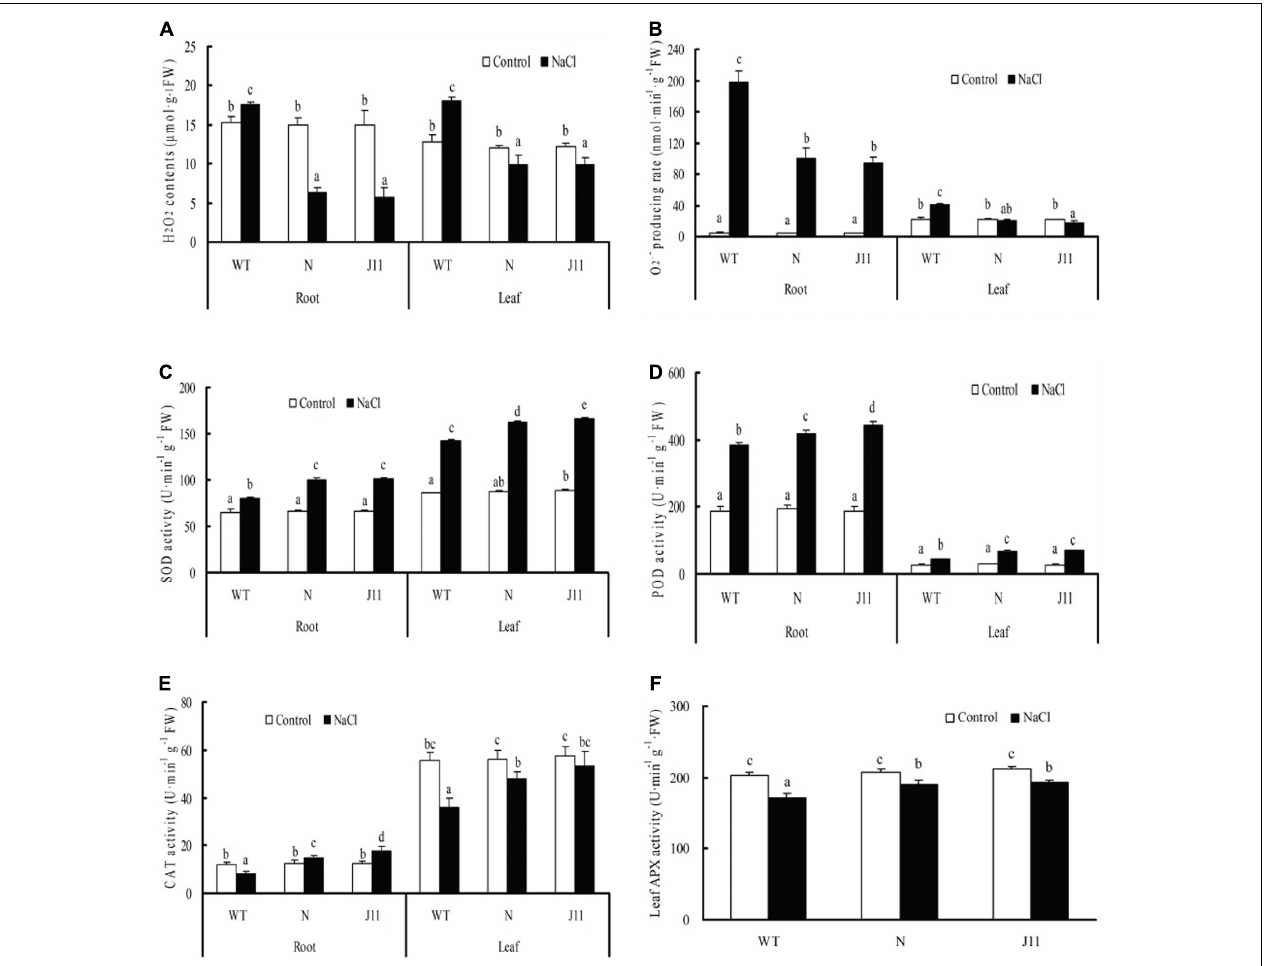
FIGURE 7 | Changes in ROS levels and antioxidant enzyme activities of plants of PgTIP1- transgenic soybean lines and WT under NaCl treatment. The plants of WT and PgTIP1 transgenic soybean lines N and J11 were cultured and NaCl-treated as above-mentioned in Figure 4 . After 7 d treatment, the roots and the 1st pair of unifoliolate leaves were sampled for measuring (A) H 2 O 2 content, (B) O •− 2 producing rate, activities of (C) SOD, (D) POD, (E) CAT, and (F) APX. Each bar represents the mean and SD of three replicates, means in bars followed by different letters show significant difference ( P < 0.05) between the parameters of WT and PgTIP1- transgenic